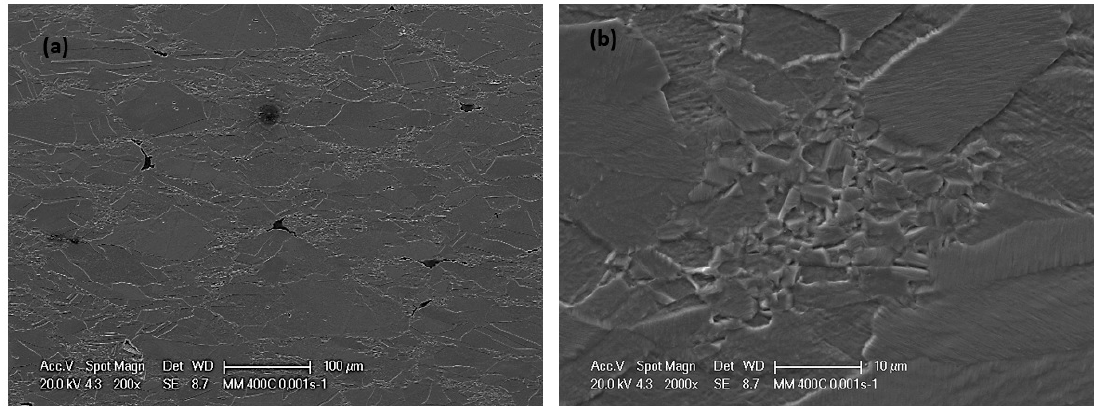
Figure 12. SEM pictures of MM deformed at 400 °C–0.001 s − 1 at ( a ) low magnification and ( b ) high magnification.